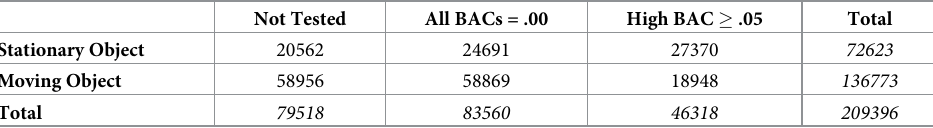
Table 2. Raw counts of crashes for stationary and moving object crashes as a function of alcohol crash